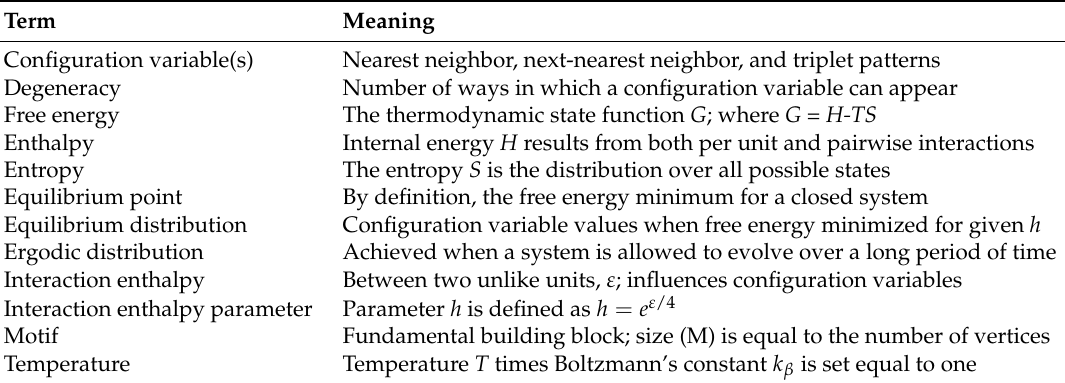
Table 1. Glossary of